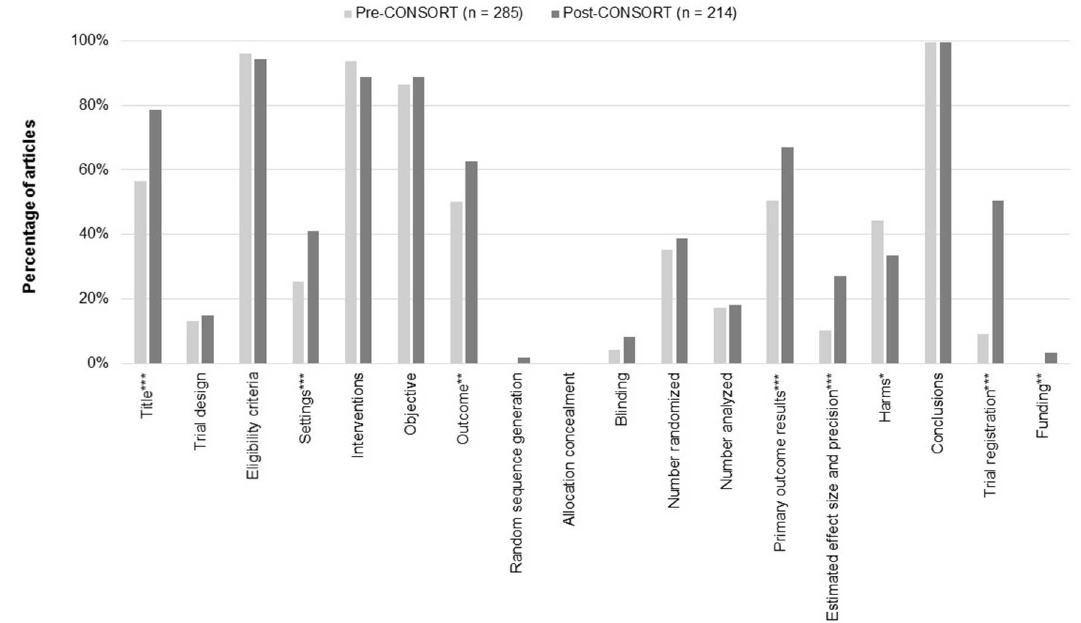
Fig 2. Reporting of CONSORT for abstract checklist items. * P < 0.05; ** P < 0.01; *** P <